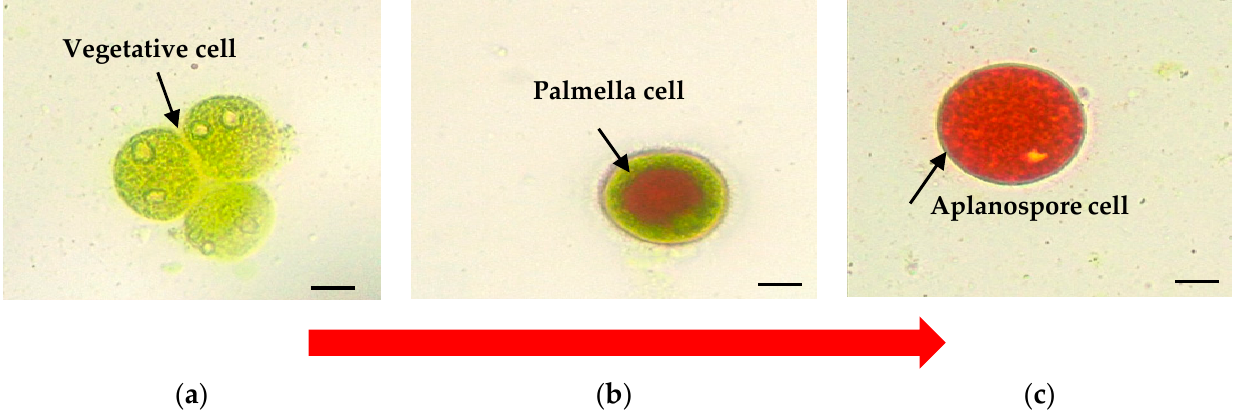
Figure 1. H. pluvialis cells photographed under the light microscope with a digital camera (Olympus B071, Olympus Optical Co., Tokyo, Japan) to observe the astaxanthin accumulation. ( a ) The vegetative stage at the beginning of the cultivation period; ( b ) the intermediate stage, wherein cells turned into greenish-orange; and ( c ) cyst stage at the end of the cultivation period; bar: 10 μ m (own source).